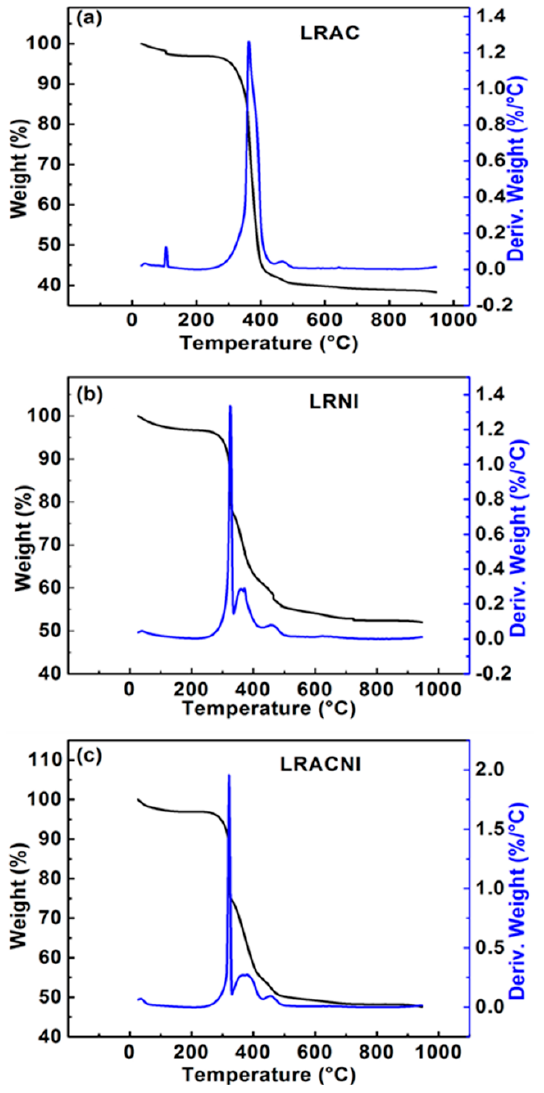
Figure 3. Thermal analysis of cornstarch with ( a ) LRAC; ( b ) LRNI; and ( c ) LRACNI, showing the weight loss and the derivative of the weight loss curves.